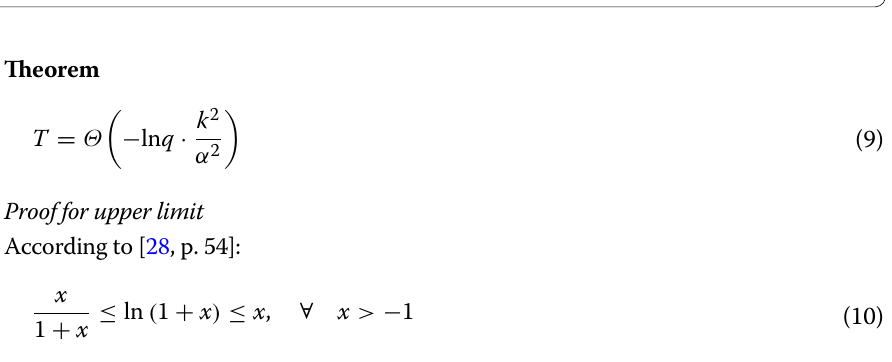
Fig. 8 Theoretical calculations for the probability of success ( p ) and failure ( q ) as a function of the iterations for S